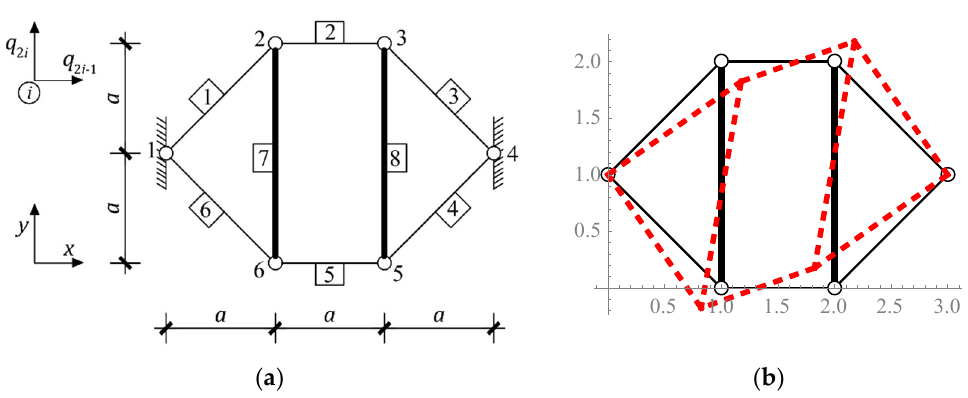
Figure 5. First pure tensegrity truss: ( a ) geometry, ( b ) infinitesimal mechanism 𝐱 (cid:2876) .